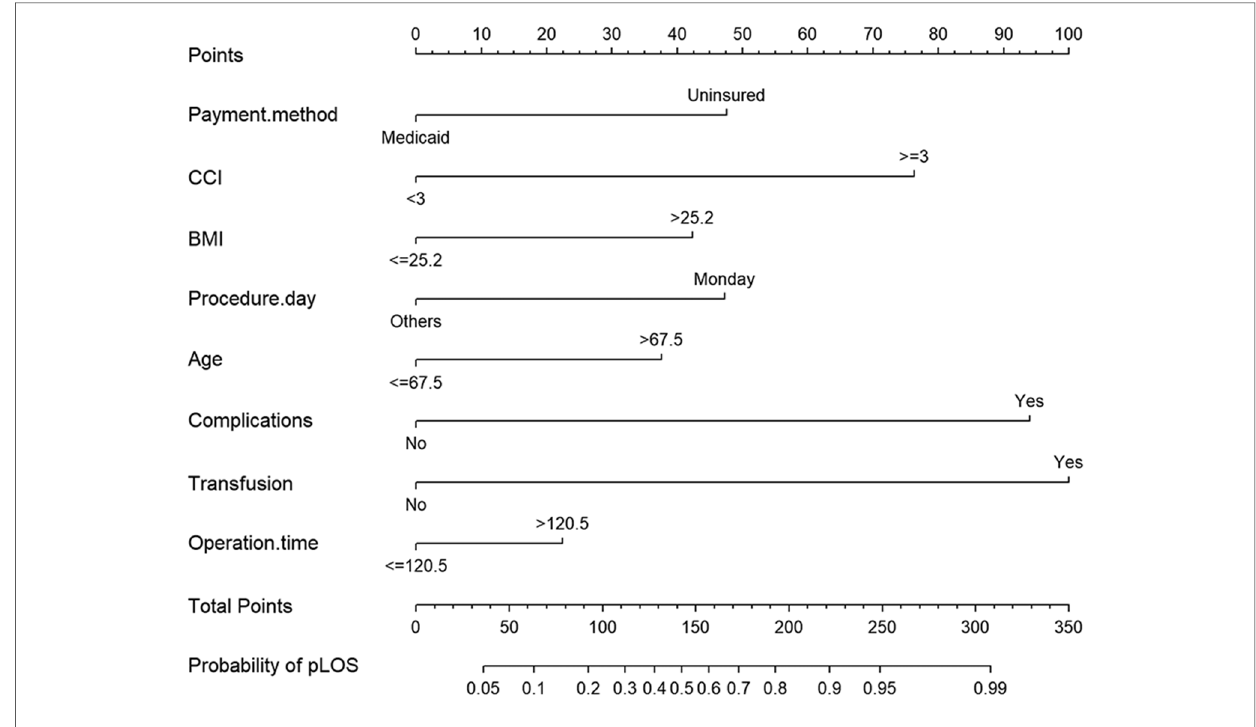
FIGURE 2 Nomogram of multivariable prediction model for LOS after TKA.